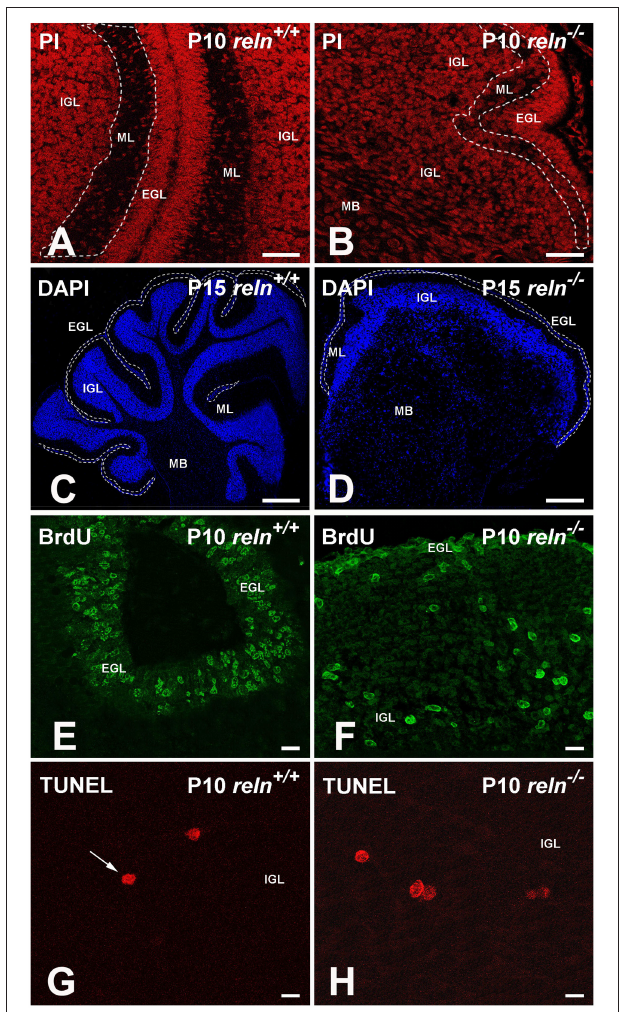
FIGURE 1 | Exemplificative images to explain the histological procedures described in Material and methods. (A,B) Propidium iodide (PI) staining was used to calculate TCD in EGL, ML, IGL and medullary body. The ML is delimited by the white dashed lines; (C,D) Reconstruction of cerebellar slices. DAPI staining allowed the identification and the measurement of the area of each cortical layer and of the medullary body. As an example of the procedure, the borders of the EGL were traced with a white dashed line. Compare the two images to easily appreciate the difference in the cytoarchitecture between the two genotypes. (E,F) BrdU immunostaining. Mice were sacrificed 2 h after the BrdU injection. The EGL has the higher density of proliferating cells in both genotypes, but in reln − / − mice its extension is clearly reduced. (G,H) TUNEL + nuclei in the IGL are intensely fluorescent and display different staining intensities. A condensed nucleus in G is indicated by the arrow. EGL, external granular layer; IGL, internal granular layer; MB, medullary body; ML, molecular layer; P, postnatal age. Scale bars: (A,B) = 25 µ m; (C,D) = 50 µ m; (E,F) = 10 µ m; (G,H) = 100 µ m.